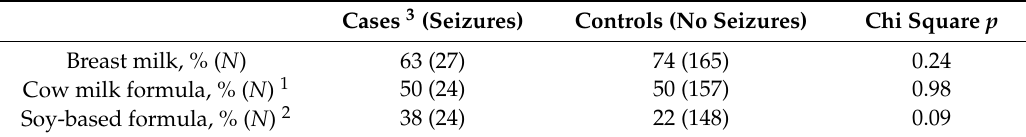
Table 4. Infant Feeding in the FXS